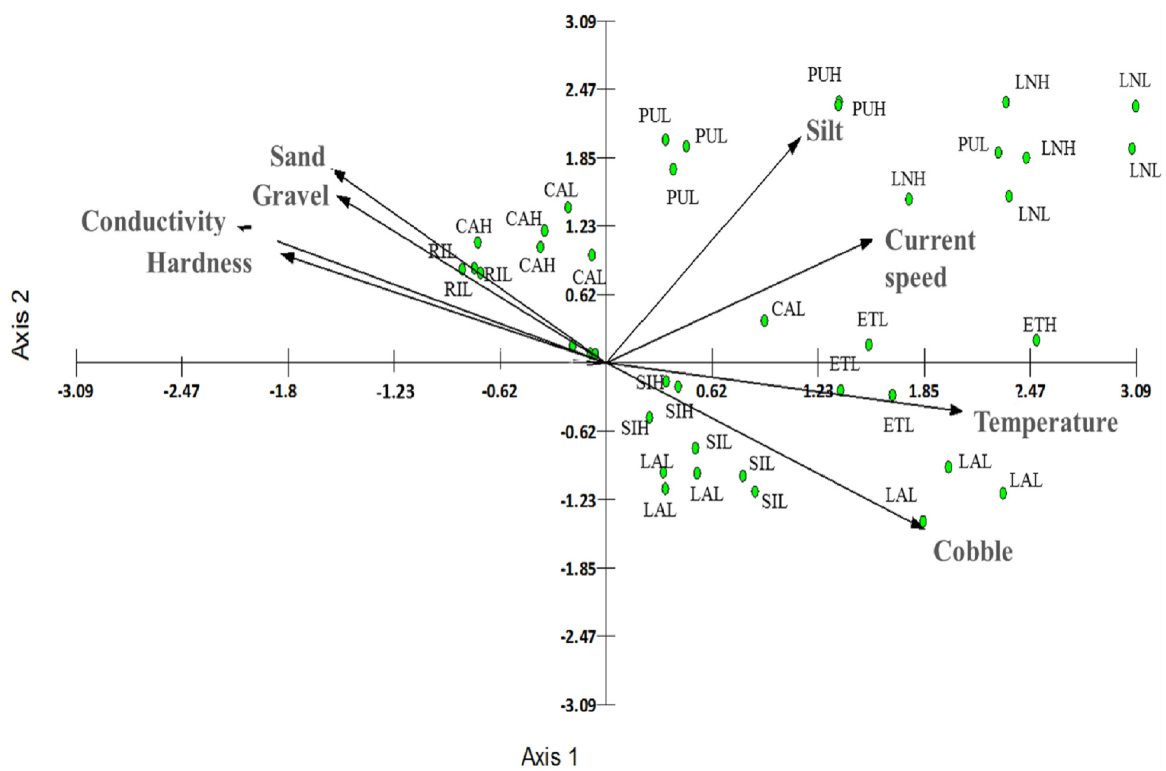
Figure 6. Canonical Correspondence Analysis between sampling sites and environmental variables (CCA) in Chaco Serrano and Puna streams. References: LN: Los Nogales, LA: Los Angeles, SI: El Simbolar, ET: El Tala, RI: Río, CA: Del Cazadero, PU: Punilla. H: high water; L: low